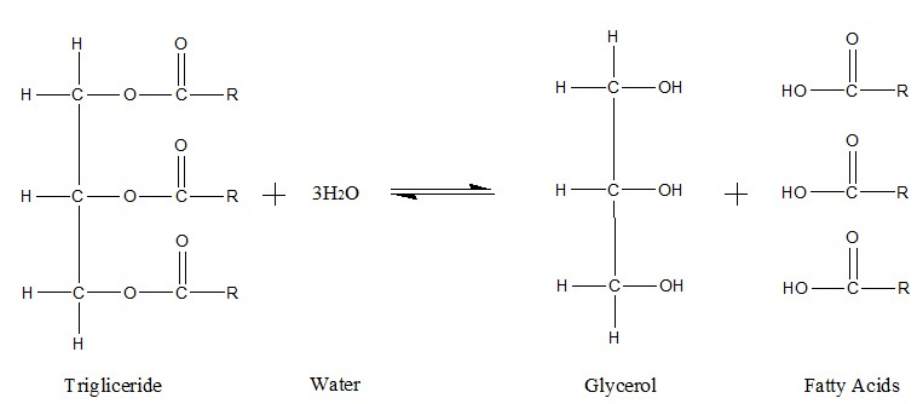
Figure 6. Hydrolisis of an